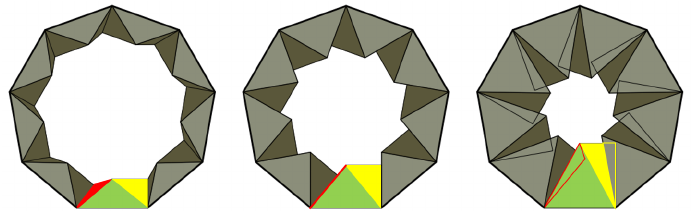
Figure 14. Top view of the three situations of the opening area during the folding process. ( n >